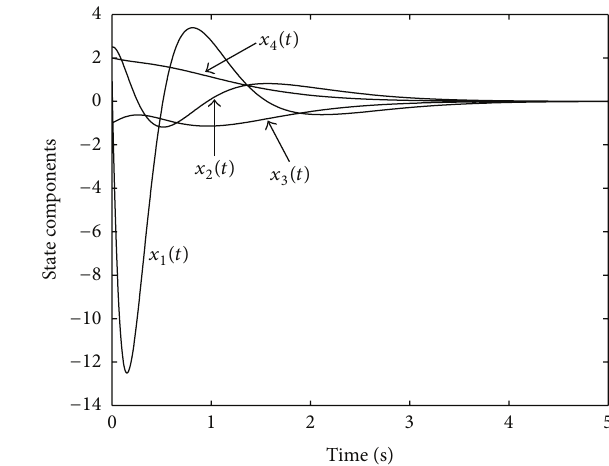
Figure 3: System output.